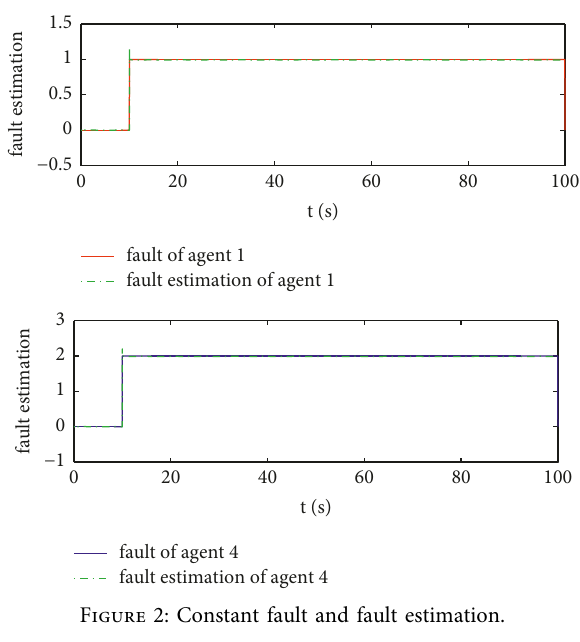
Figure 2: Constant fault and fault estimation.